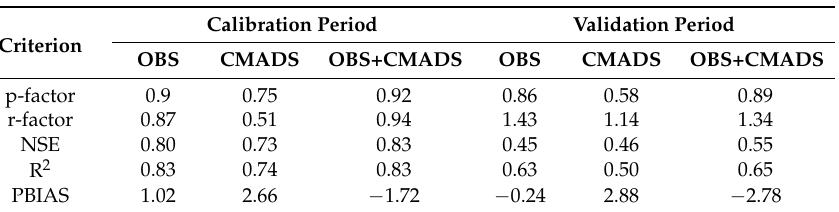
Table 11. The criterion value for the simulated streamflow of SWAT model with different driving data during the calibration and validation periods.